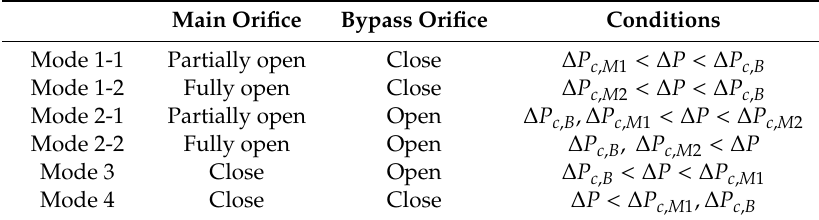
Table 1. Several types of flow